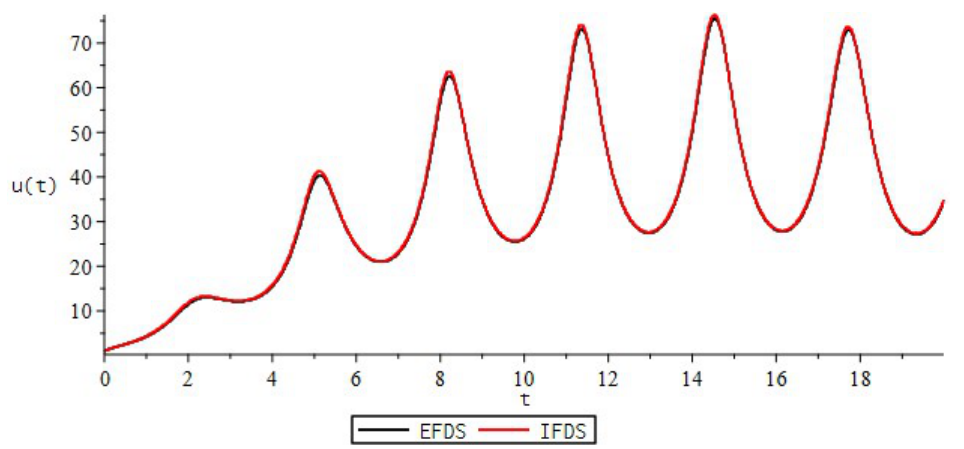
Figure 6. Numerical solutions of the fractional Riccati equation with variable coefficients α ( t ) = 0.4 + 0.5 t / T —monotonically increasing function.